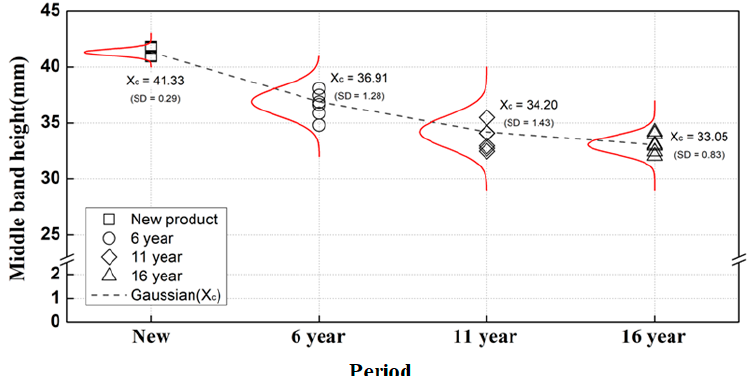
Figure 7. Measured residual strain of the middle band according to the service period for tension clamps.